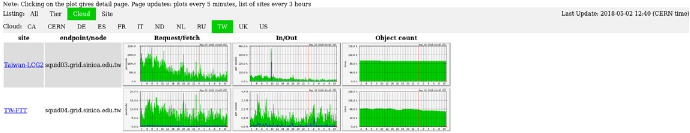
Figure 7. MRTG monitoring page